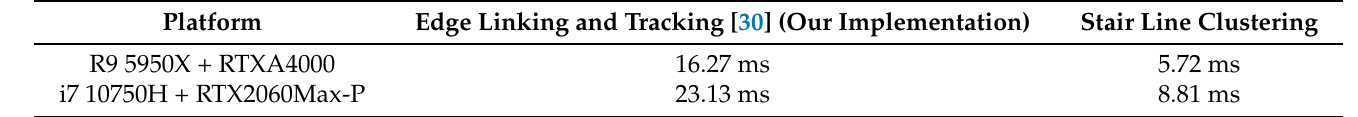
Table 7. Experimental results of the stair line clustering algorithm.